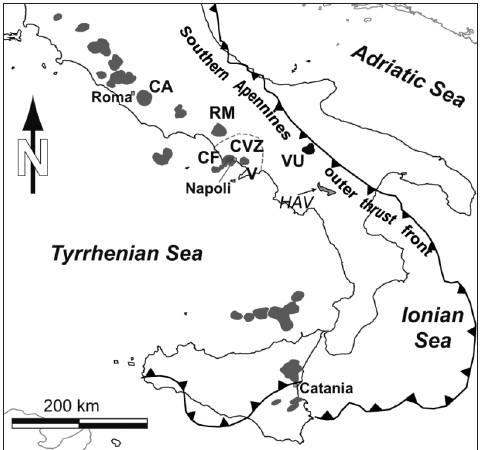
Fig. 1. Location map of the High Agri Valley (HAV) and distribution of the main volcanic districts along the central-southern Italy (dark areas). Key to abbrevia- tions (from north to south): CA – Colli Albani; RM – Roccamonfina; CVZ – Campanian Volcanic Zone (within dashed line); CF – Campi Flegrei; V – Vesu- vius; VU – Mt. Vulture; HAV – High Agri Valley.